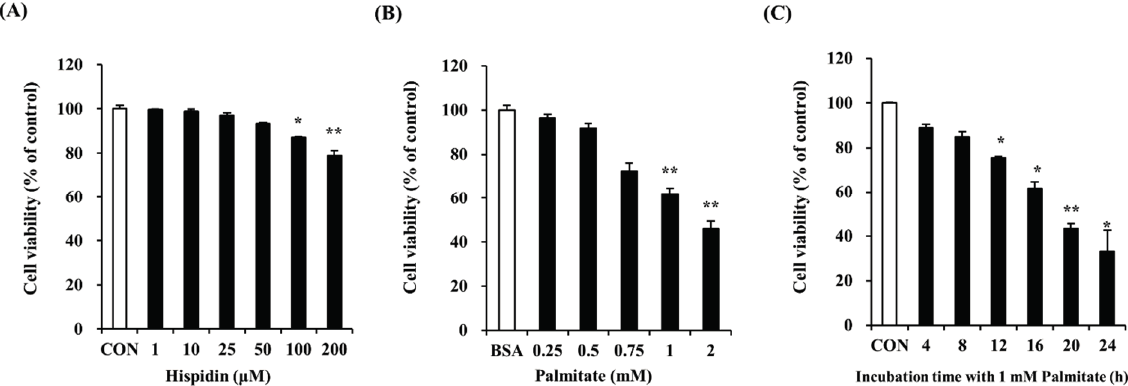
Figure 1. Effect of hispidin and palmitate on C2C12 myotubes viability. ( A )